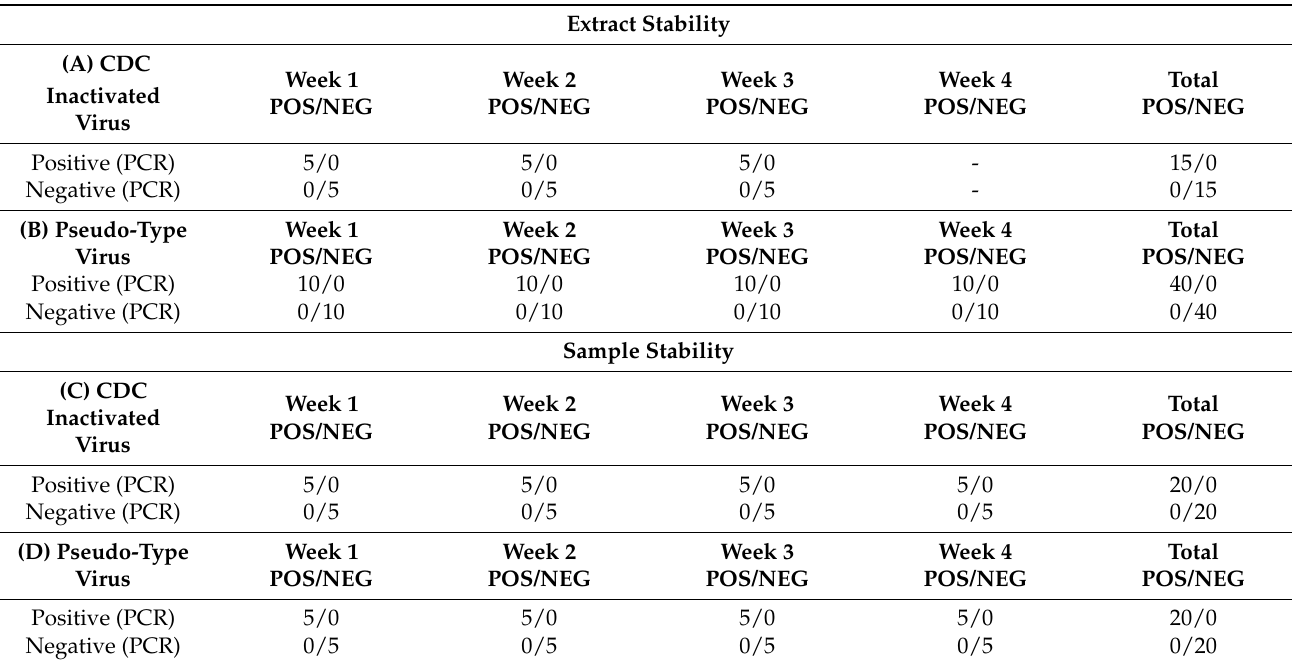
Table 5. Composite tabulation of storage stability of saliva/gargle spiked samples containing in- activated SARS-CoV-2 virus (CDC inactivated virus ( A , C )) and pseudotype expressing SARS-2 spike protein ( B , D ), as processed acetone precipitate “Extract” ( A , B ) and as complete frozen mock “Sample” ( C , D